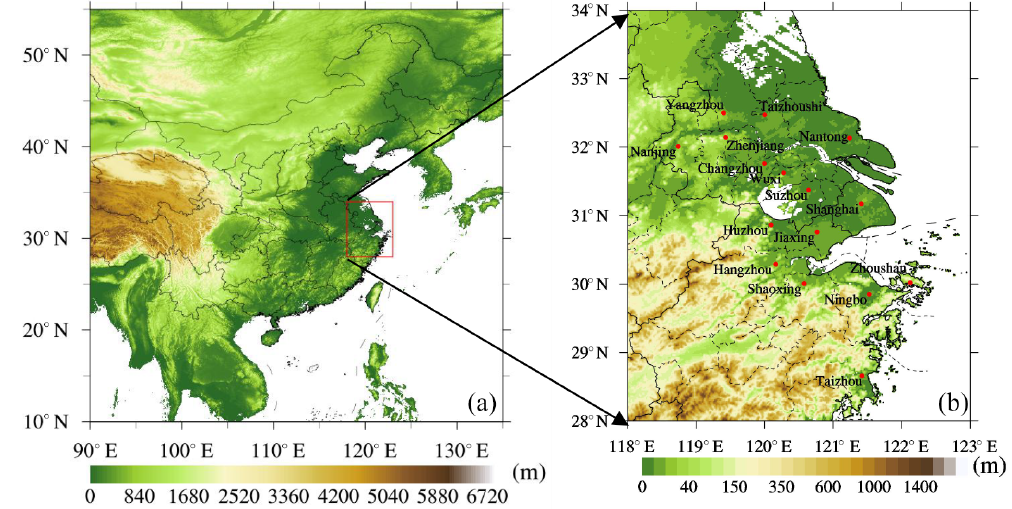
Figure 1. The location of the YRD in China (a) and 16 typical cities in the YRD (b) , with terrain elevation data. The terrain elevation data are obtained from the website